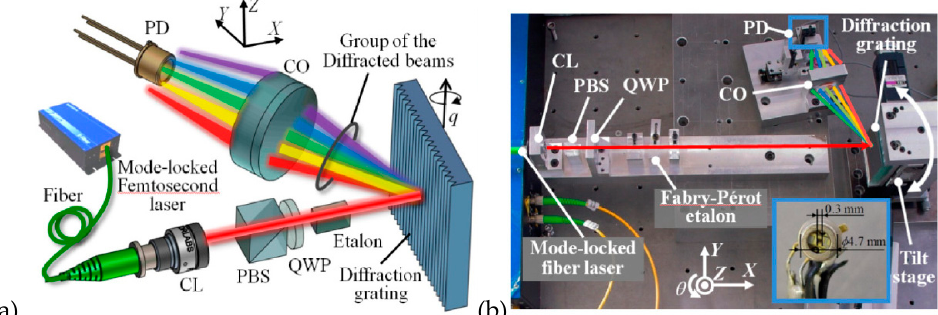
Figure 4. Optical setup of the mode-locked femtosecond laser autocollimator [55]: ( a ) A schematic of the optical setup; ( b ) A photograph of the optical setup.